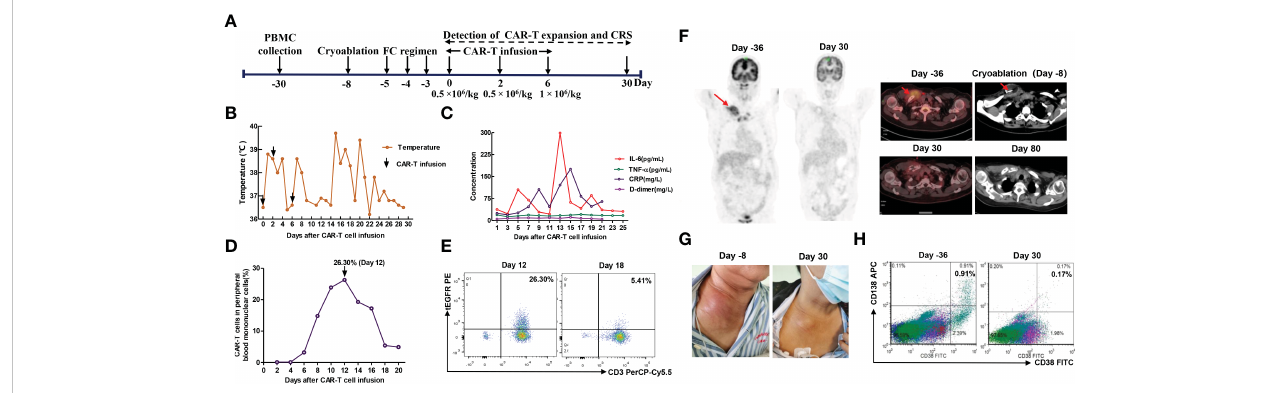
FIGURE 2 (A) Timeline of patient preparation and CAR-T therapy for patient 1 from peripheral blood collection to 1 month after anti-BCMA CAR-T cell infusion, including bridging cryoablation, lymphodepleting chemotherapy, and CAR-T infusion. (B) Changes in body temperature after CAR-T cell infusion. (C) The